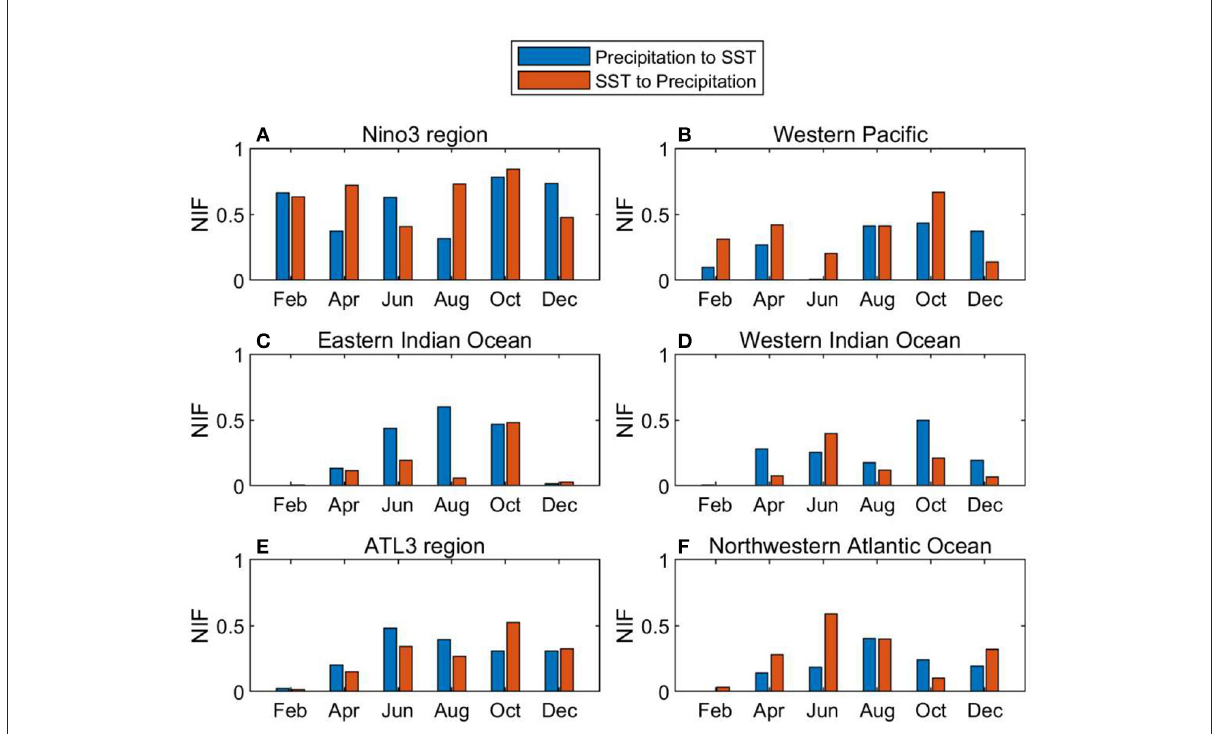
FIGURE7 NIFs between regional average SST and precipitation for February, April, June, August, October, and December in (A) the Niño-3 region (150–90 ◦ W, 5 ◦ N 5 ◦ S), (B) the western equatorial Pacific (120–140 ◦ E, 5 ◦ N − 10 ◦